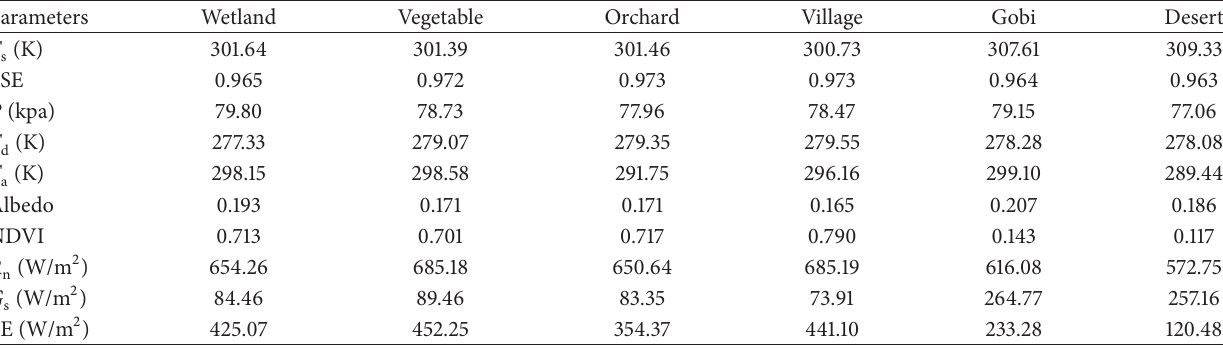
Table 4: Average of input parameters derived by MODIS products at the six sites, including land surface temperature ( 𝑇 s ), near-surface air temperature ( 𝑇 a ), land surface emissivity (LSE), near-surface pressure ( 𝑃 ), dew point temperature ( 𝑇 d ), albedo, and NDVI. The retrieved net radiation ( 𝑅 n ), soil heat flux ( 𝐺 s ), and latent heat flux (LE) are also shown. Parameters Wetland Vegetable Orchard Village